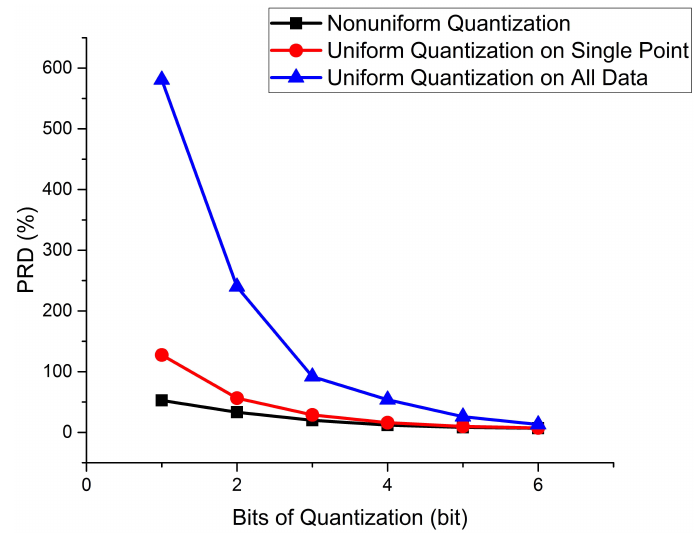
Figure 6. Influence of different quantization methods on